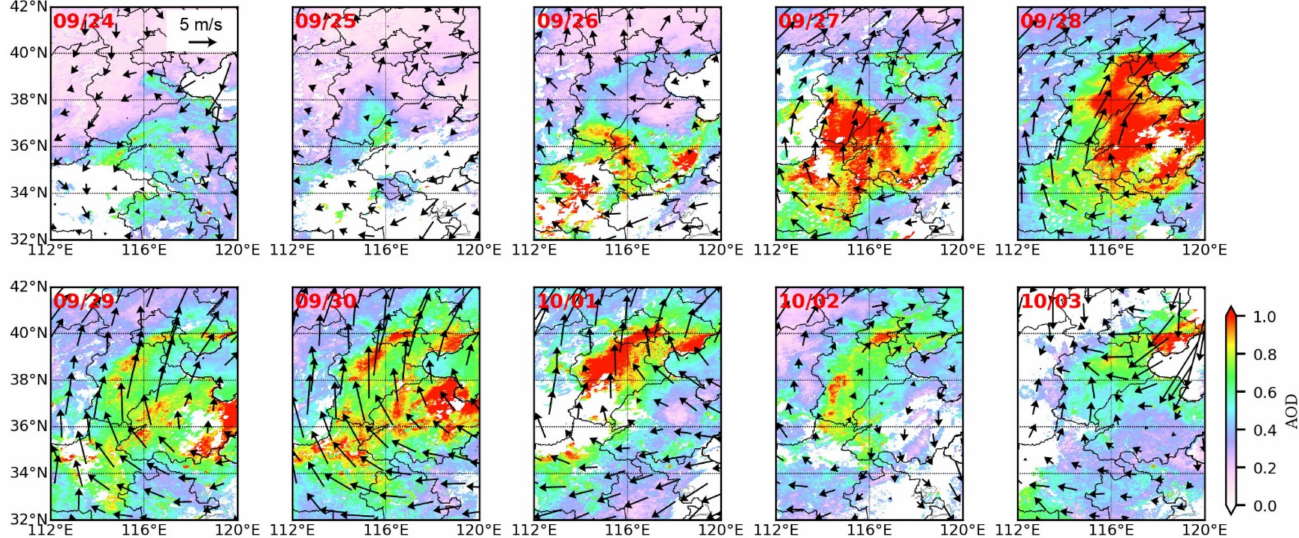
Figure 9. Spatial distribution of the daily AOD from 24 September to 3 October 2019 retrieved from the Moderate Resolution Imaging Spectrometer (MODIS). The black arrows overlaid on the map represent the surface wind speed and direction. The date is displayed at the top left of each